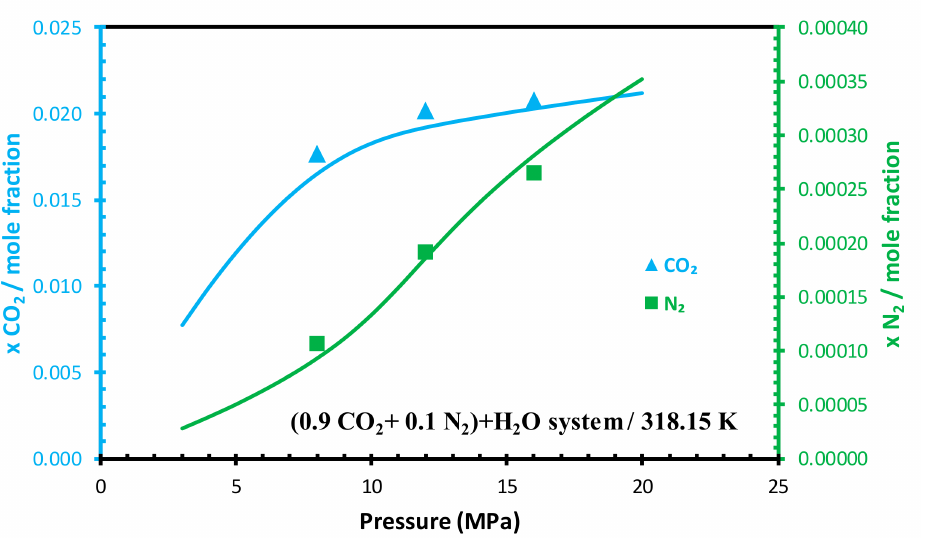
Figure 9. Mixed-gas cosolubility in CO 2 + N 2 + H 2 O system: Comparison of SW EoS predictions (solid lines) with experimental literature data (symbols)